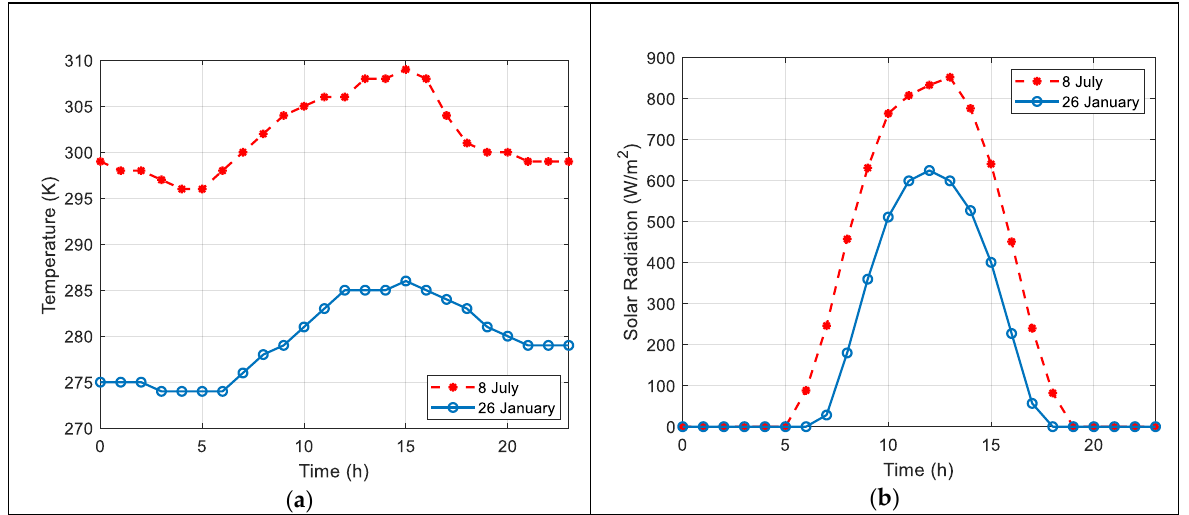
Figure 3. Weather Data for Melbourne, FL, USA: ( a ) ambient temperature; ( b ) solar irradiation.